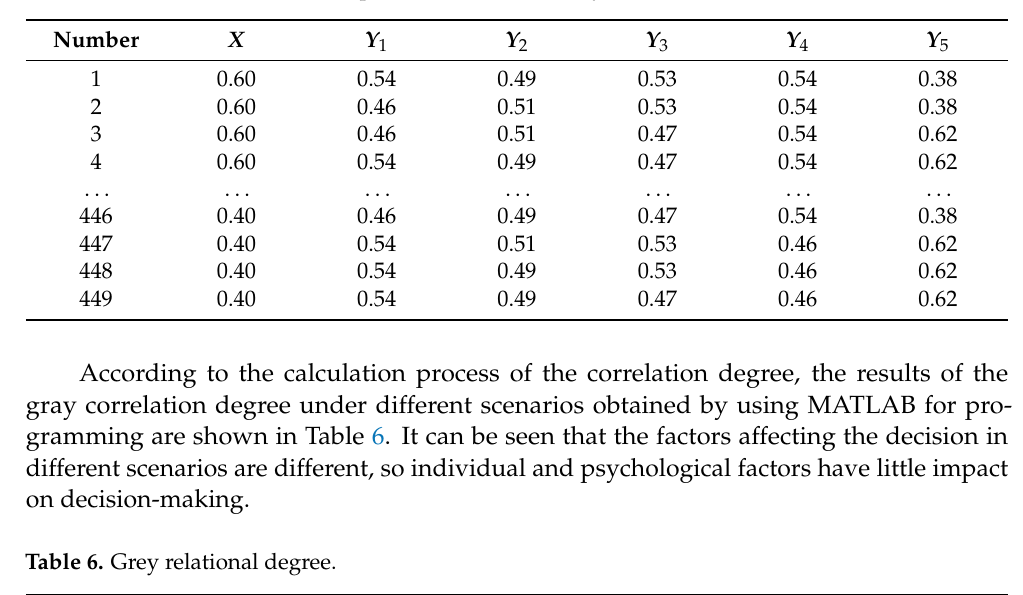
Table 5. Quantitative results of experimental data in study 1.